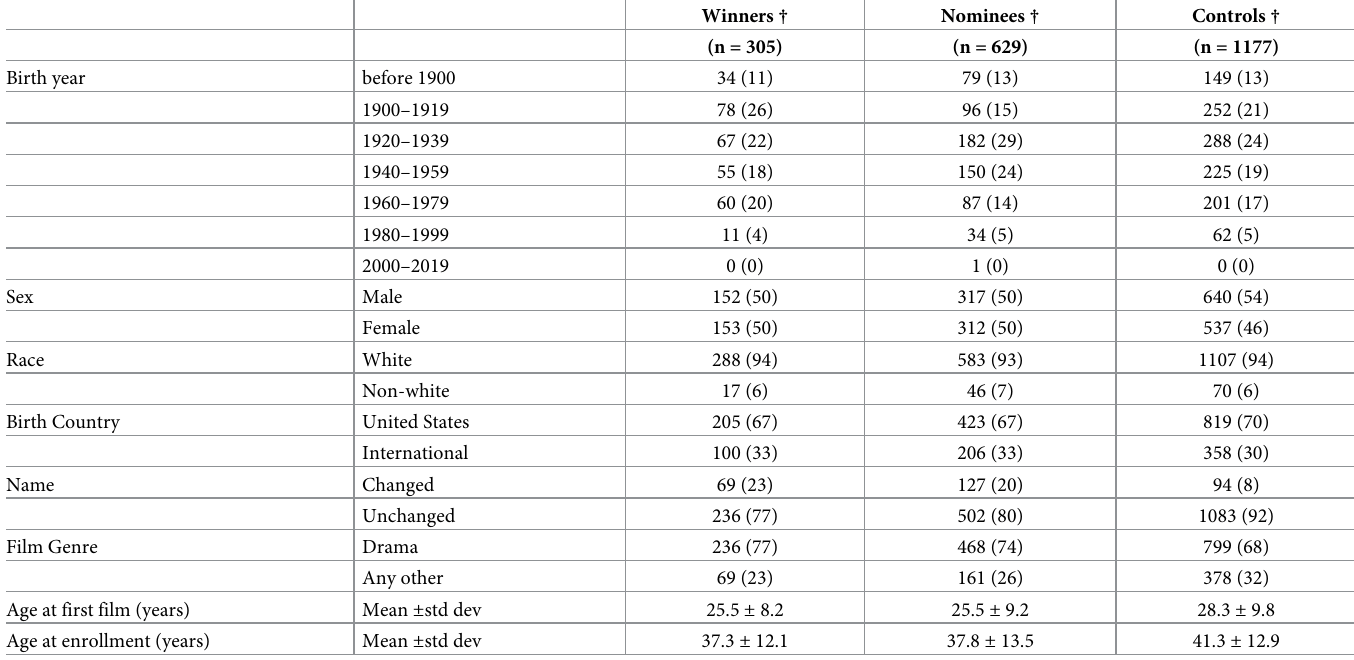
Table 1. Baseline characteristics � .